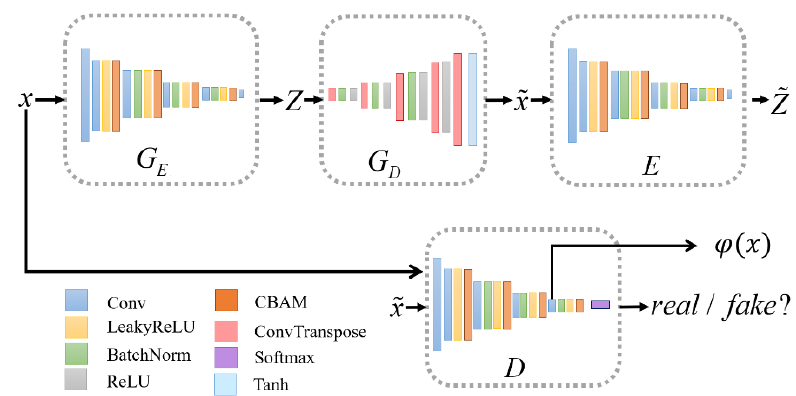
Figure 3. Pipeline of the generative adversarial network for anomaly detection. Table 1. Details of the encoder parameters.